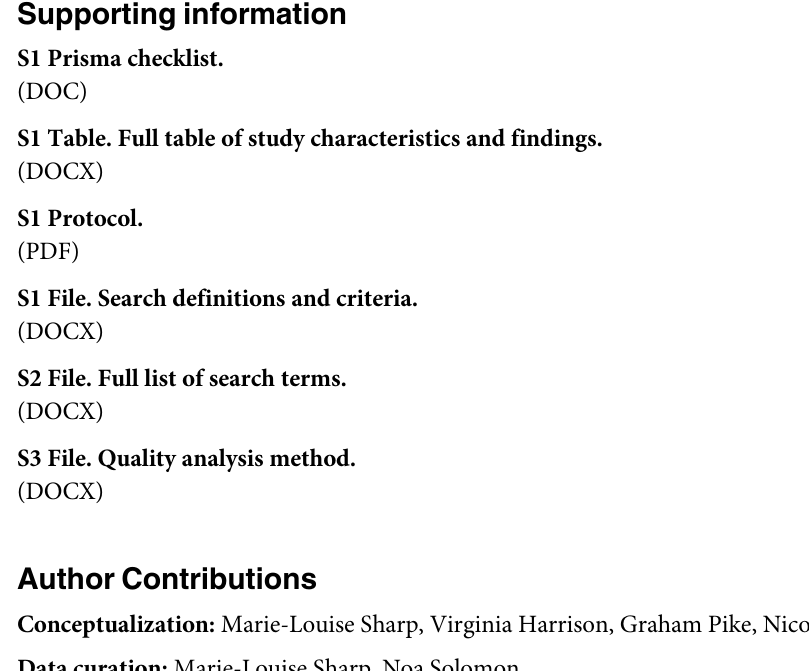
S1 Table. Full table of study characteristics and